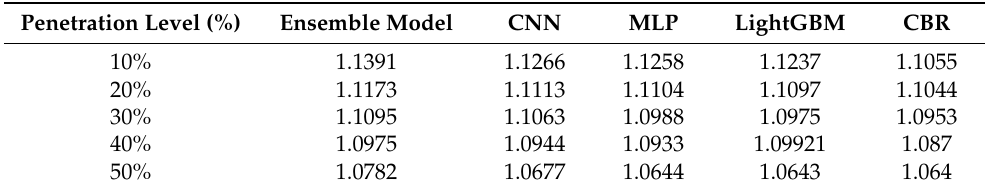
Table 4. The average comprehensive objective function for reactive power optimization of distribution networks with renewable energy